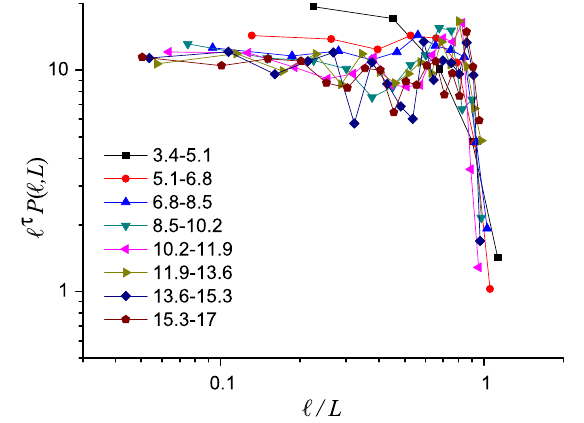
FIG. 6. Collapse of the data in Fig. 5, showing finite-size scaling. The graphs correspond to the field intervals listed in the key (mT).